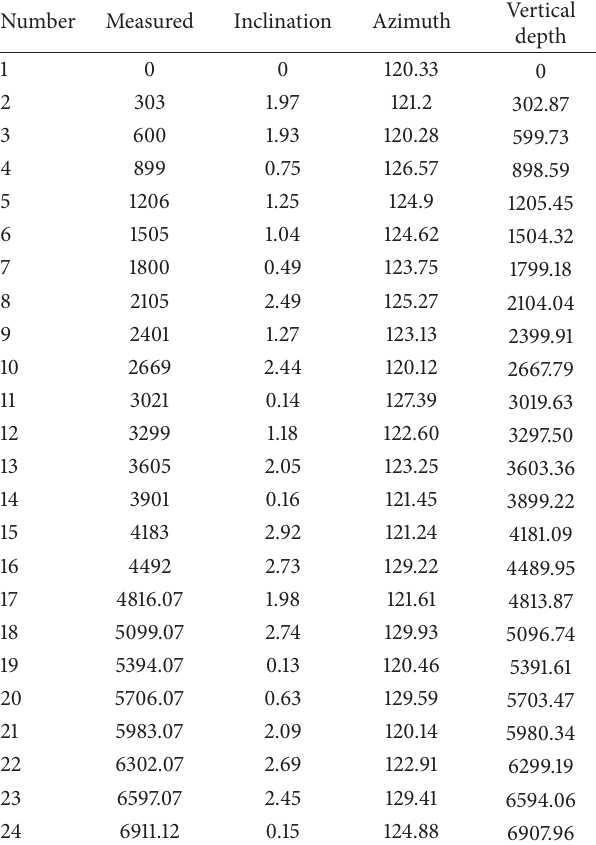
Table 2: Parameters of azimuth, inclination, and vertical depth.